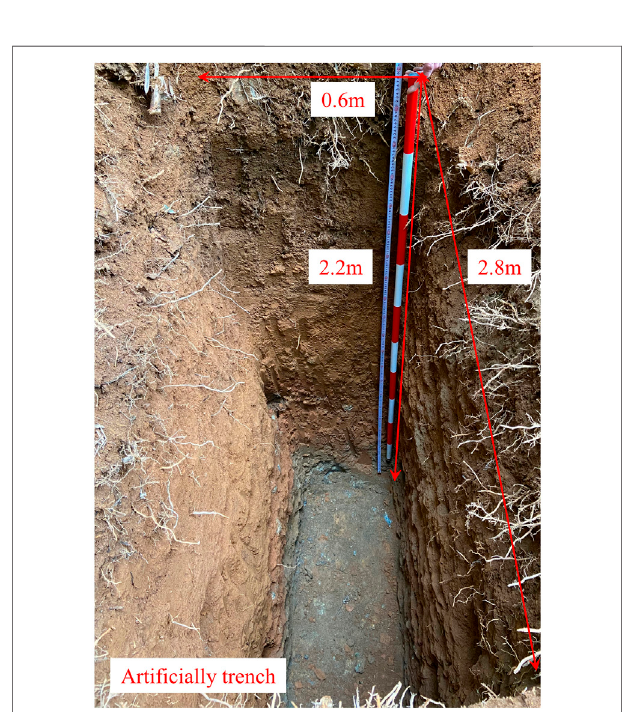
FIGURE 2 | In-situ arti fi cially